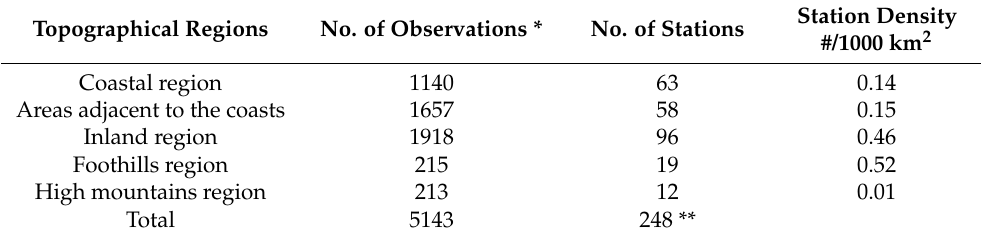
Table 4. Rain gauge distribution in each topographical region.